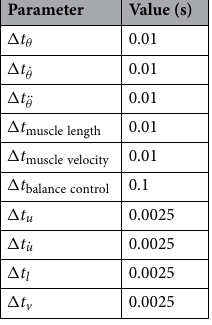
Table 1. Transport delays.